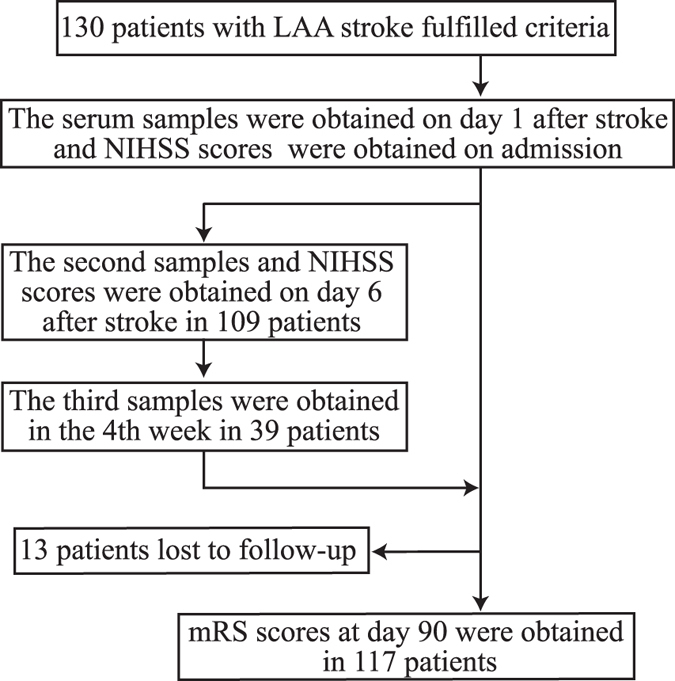
Study flow chart Abbreviations.LAA stroke, large artery atherosclerotic stroke; NIHSS, National Institutes of Health Stroke Scale; mRS, modified Rankin Scale.